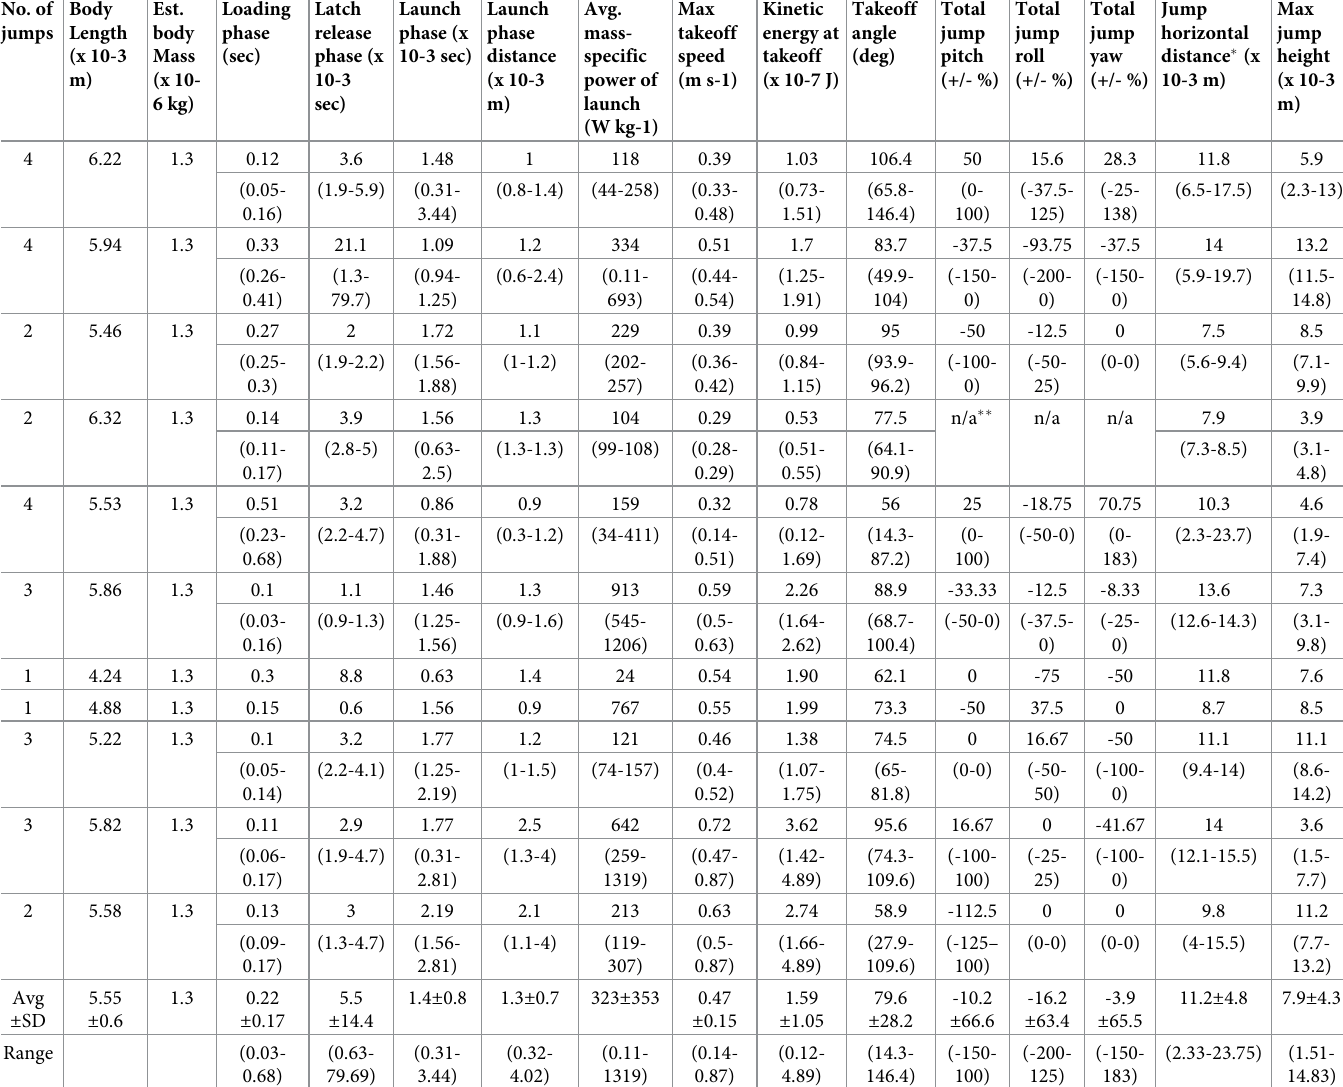
Table 2. Jump kinematics based on high-speed imaging from several larvae of Laemophloeus biguttatus . No. of Body jumps